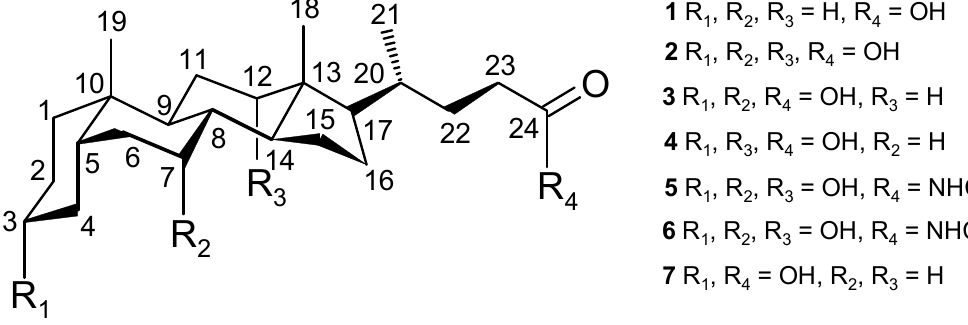
Figure 1. Structures of the most important bile acids and their glycine and taurine conjugates.